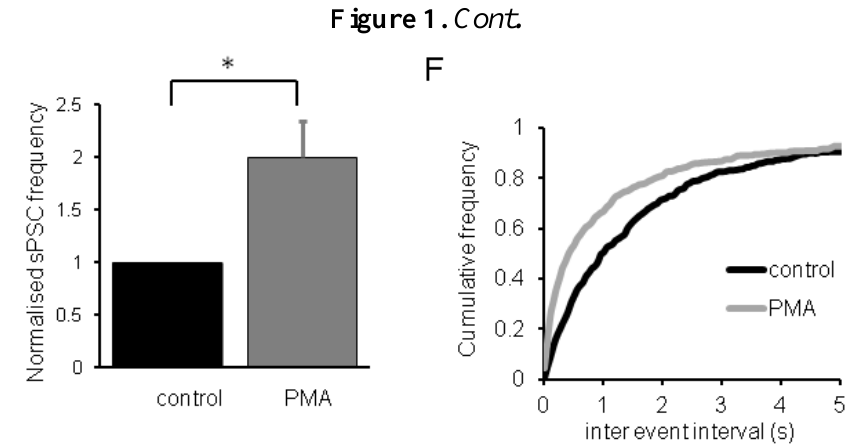
Table 1. Effects of PMA on sPSCs in dorsal horn neurones in litter-matched WT